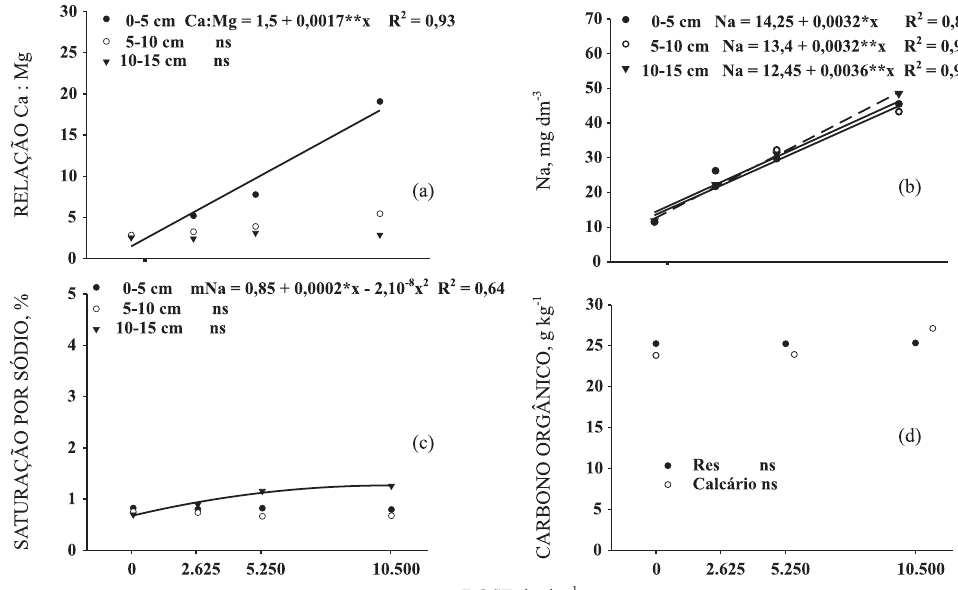
Figura 2. Relação Ca:Mg (a), teores de Na (b), saturação por Na (c) e carbono orgânico (d) do Cambissolo Húmico alumínico submetido a doses de resíduo alcalino aplicadas em superfície, calculadas com base no método SMP. (*, ** e ns: significativos a 5 e 1 % e não